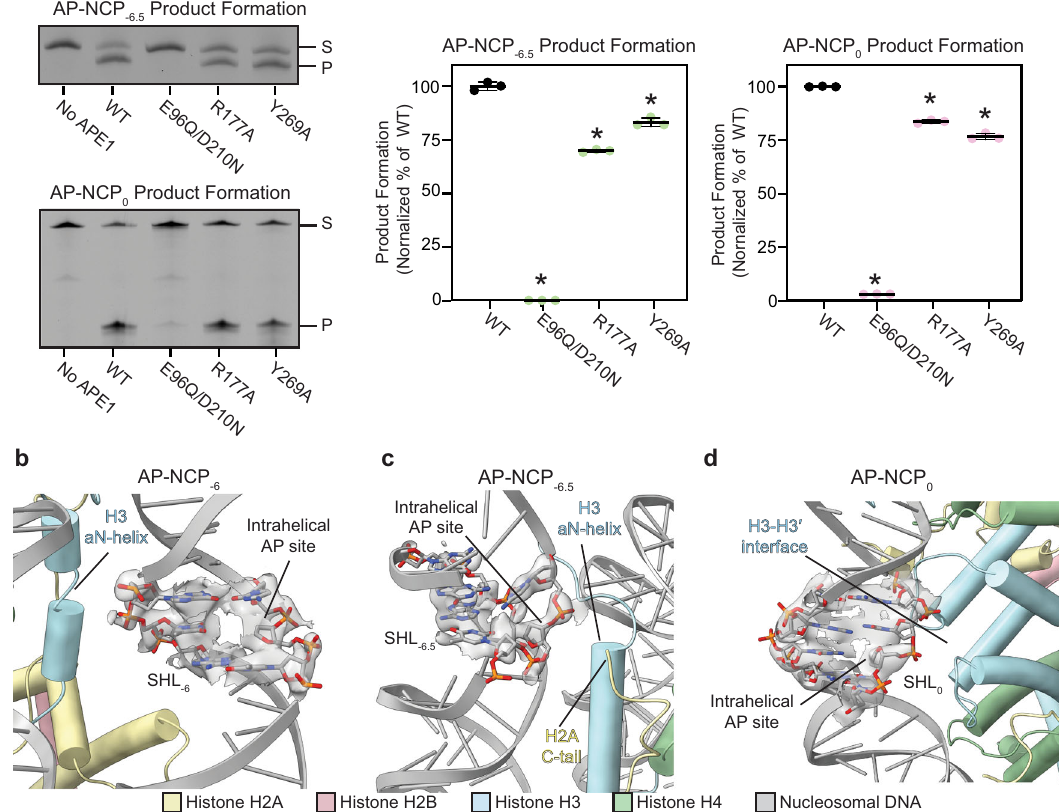
Fig. 5 | Mechanism for APE1 processing occluded AP sites in the nucleosome. a Representative gelsof the AP-NCP − 6.5 and AP-NCP 0 productformation assays for WT, E96Q/D210N, R177A, and Y269A APE1 (left). The substrate (S) and product (P) bands were detected using the 6-FAM label. Quanti fi cation of the AP-NCP − 6.5 and AP-NCP 0 product formation assays for WT, E96Q/D210N, R177A, and Y269A APE1 (right).The data shown are the mean±standard deviation from the threereplicate experiments.The*denotesvaluesthataresigni fi cantlydifferent( p <0.01)thanWT